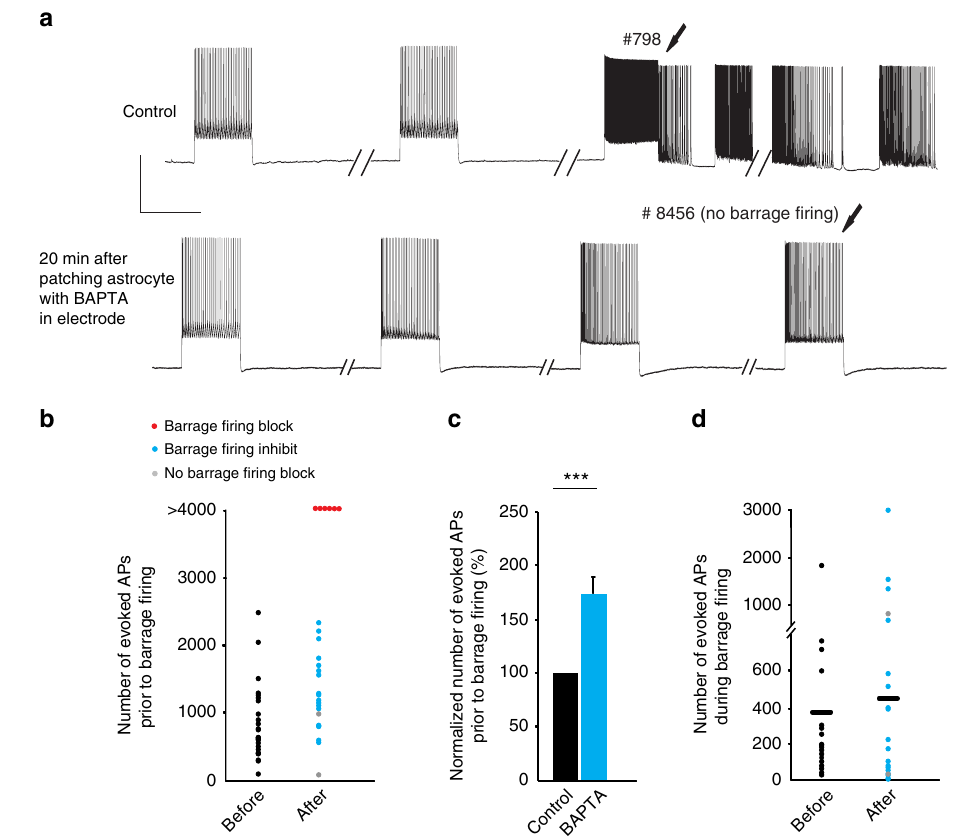
Fig. 4 Chelating intracellular calcium in astrocytes inhibits barrage fi ring. a Barrage fi ring induction in an NPY interneuron (control). Barrage fi ring could not be induced in the same interneuron after chelating Ca 2 + in the astrocytic network by patching a nearby astrocyte with an electrode containing 50 mM BAPTA. Scale bars, 40 mV, 1 s. b The number of evoked spikes to induce barrage fi ring before (black, n = 26 from 20 mice) and after chelating Ca 2 + in astrocytic network. In some cases, barrage fi ring was never induced after astrocytic BAPTA (red, n = 6 from 6 mice); in some cases, more spikes were required to induce barrage fi ring (blue, n = 18 from 12 mice); in some cases, barrage fi ring was unaffected (gray, n = 2 from 2 mice). c The number of spikes required for barrage fi ring induction increased after astrocytic BAPTA. Normalized number of spikes is calculated only in trials where barrage fi ring was observed after chelation (blue and gray points in b ; n = 20 , paired t test, *** p = 0.00013). d The number of spikes during barrage fi ring did not change signi fi cantly following astrocytic calcium chelation with intracellular BAPTA (blue and gray points in b , n = 20). Data are represented as mean ± fi ring induction (484 ± 121 spikes during photostimulation vs. 689 ± 167 spikes in control, n = 5; paired t test, p = 0.03, Sup-